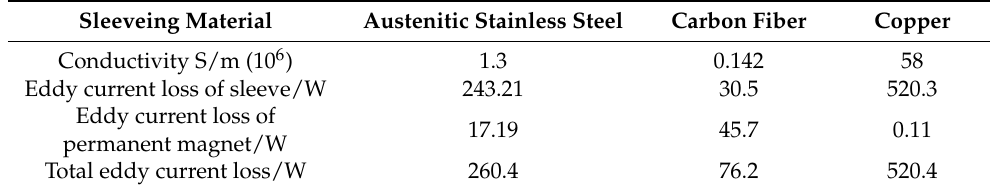
Table 3. The rotor eddy current loss under load conditions with a jacket thickness of 1 mm for different materials.